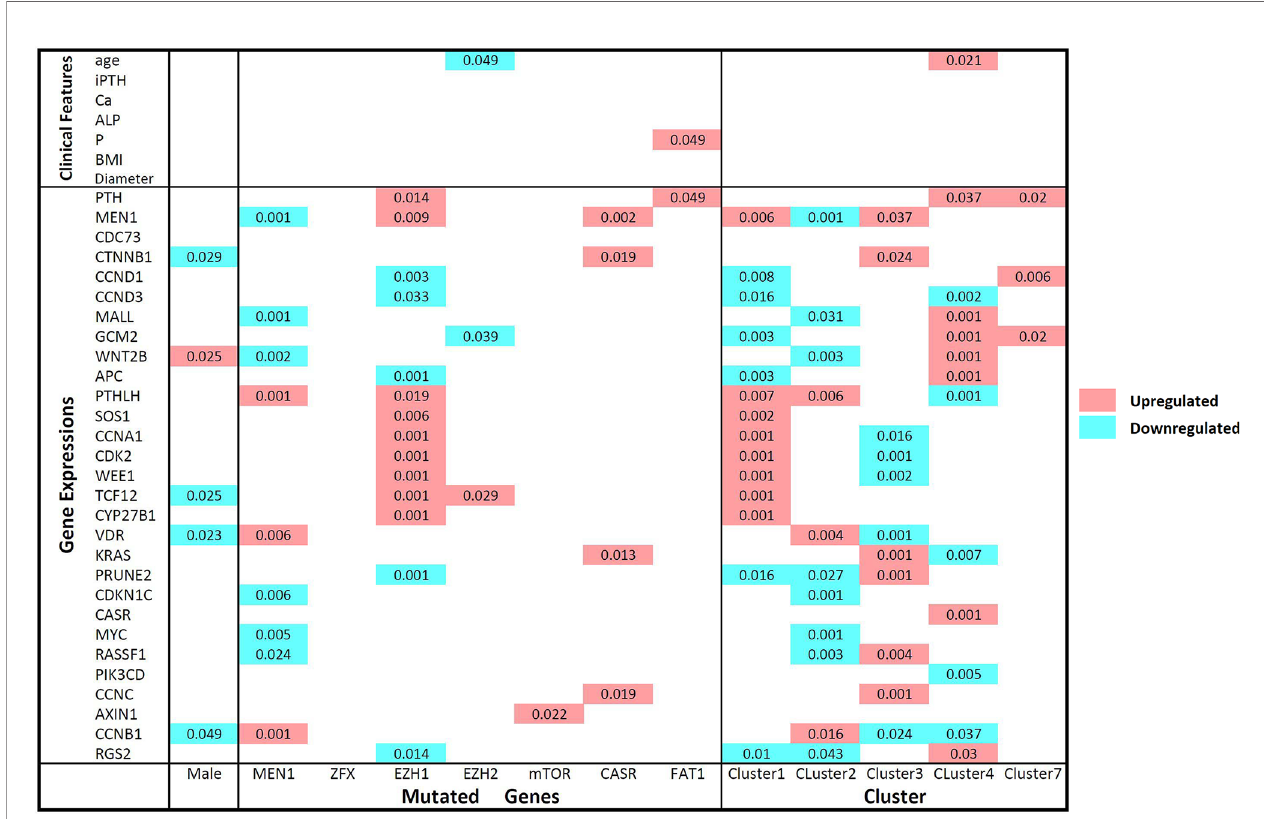
FIGURE 3 | Comparisons of gene expression levels and clinical features between mutant and wild-type parathyroid adenomas and between clusters according to the Mann-Whitney U test. The names of the mutated genes and clusters names are listed on the horizontal axis, and the gene expression level and clinical features are shown on the vertical axis. Comparisons of wild-type and mutant parathyroid adenomas and different clusters: upregulated and downregulated expression levels in samples with the mutant genotype or in certain clusters are represented by red and blue, respectively. P-values less than 0.05 are marked in the matrix. iPTH, serum intact parathyroid hormone level; Ca, serum calcium level; ALP, serum alkaline phosphatase level; P, serum phosphorus level; BMI, body mass index; Diameter, maximum diameter of the parathyroid